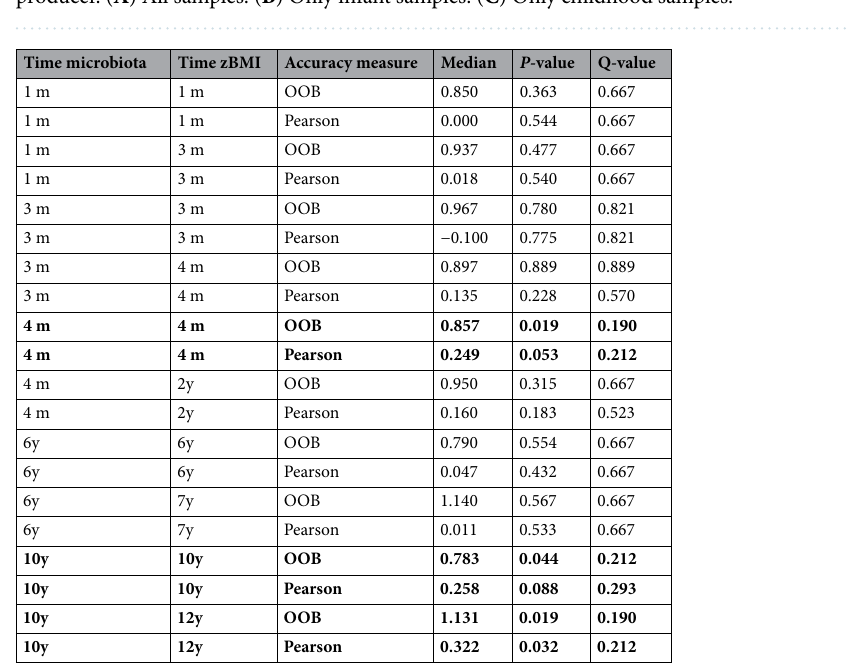
Figure 4. Posterior distribution (median and 95% credible interval) of β coefficients (slopes) per SCFA producer. ( A ) All samples. ( B ) Only infant samples. ( C ) Only childhood samples.